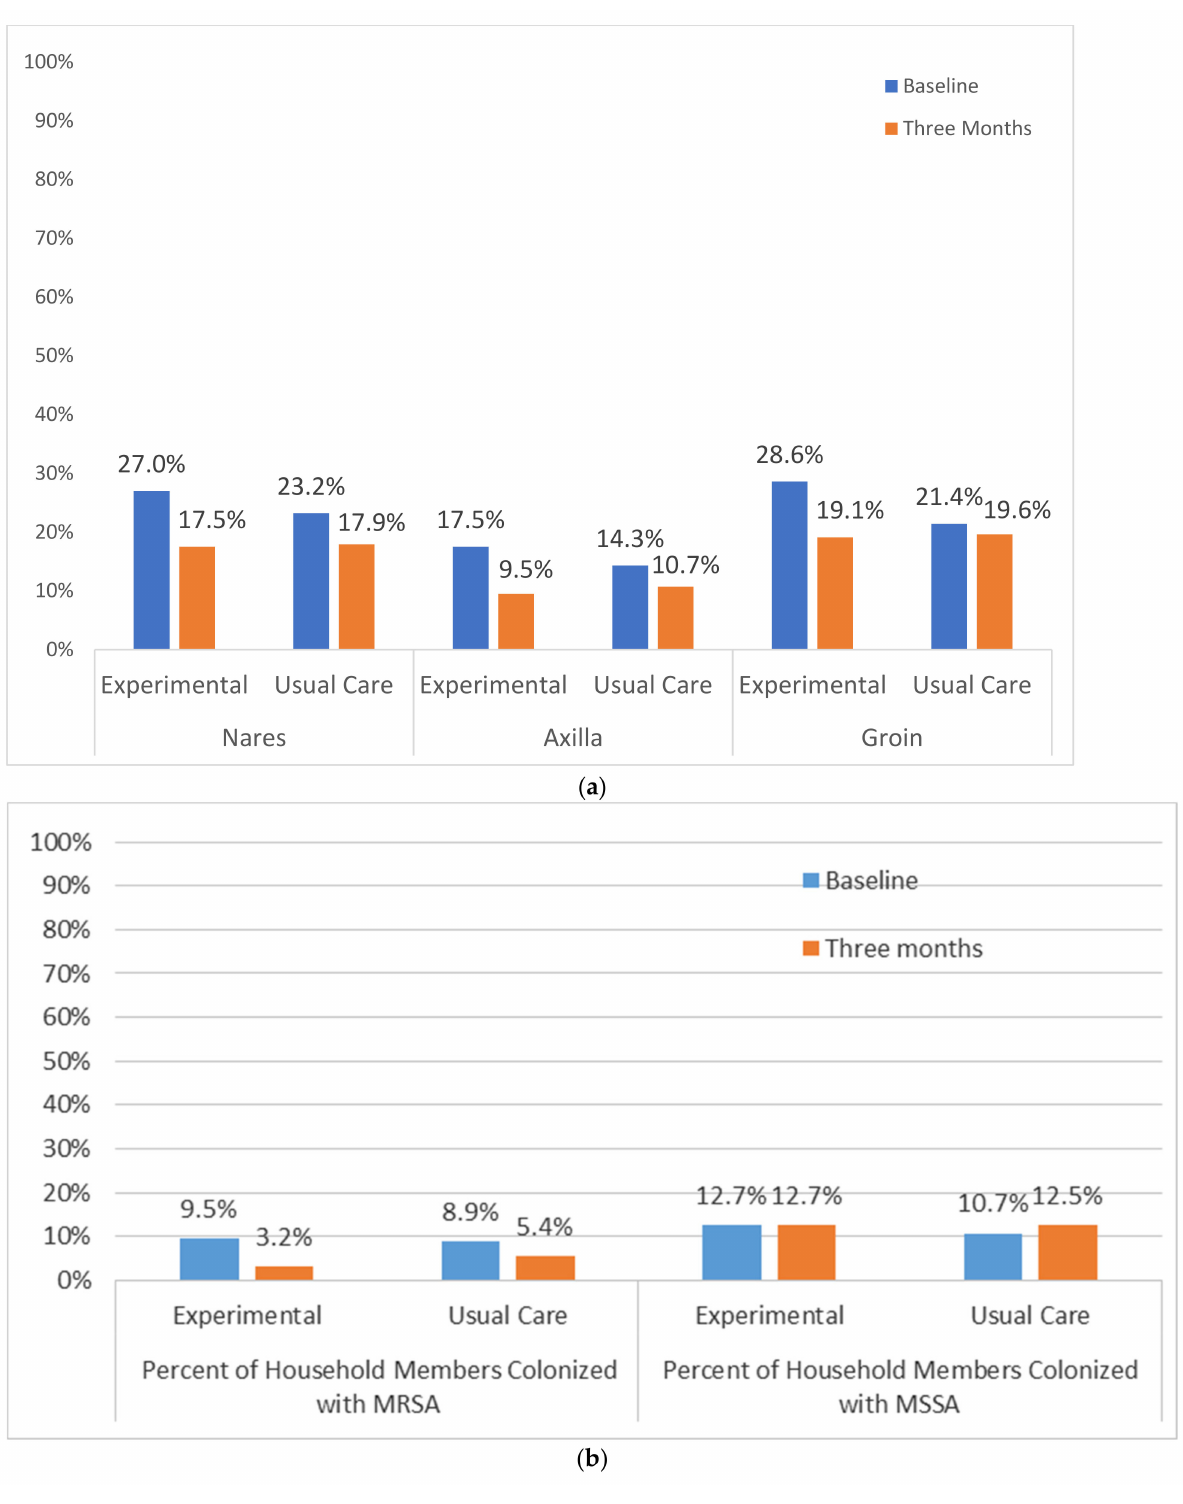
Figure 4. ( a ) Proportion of household members colonized with S. aureus , by colonization site at baseline and three month follow-up household visits. ( b ) Household members colonized with MRSA vs. MSSA by treatment group at baseline and three-month follow-up household visits. Note: In addition to the Index Patient information provided above, 64% of household members participated in the study and provided surveillance cultures (EXP = 67.5%, UC = 60.2%, p = 0.34) There were no significant differences by treatment group in the number of co-residents in households where the index patient had a MRSA wound (EXP = 2.4 vs. UC = 3.4, p =